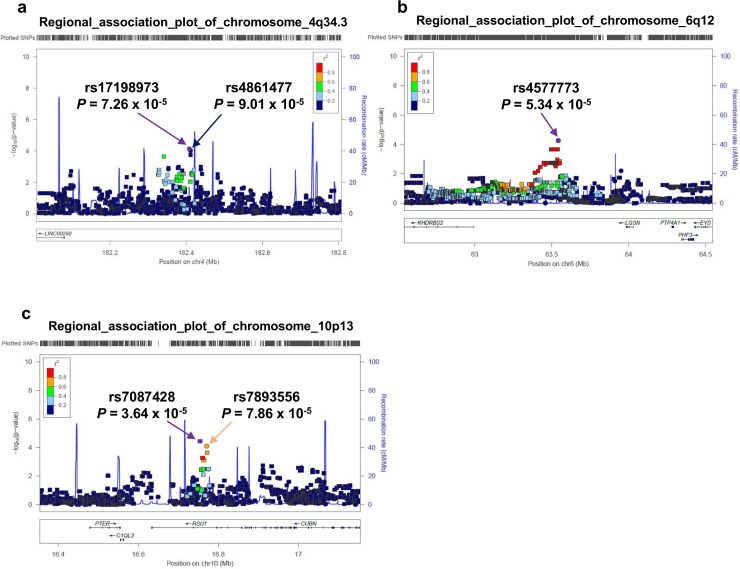
Regional association plots for three loci possibly associated with Ki-67 response after preoperative tamoxifen therapy.Upper panel; P values of genotyped SNPs (circle) and imputed SNPs (square) are plotted (as −log10P value) against their physical location on chromosome 4q34.3 (a), 6q12 (b) and 10p13 (c). The genetic recombination rates estimated from 1000 Genomes samples (JPT + CHB) are shown with a blue line. SNP's color indicates LD with rs17198973 (a), rs4577773 (b) and rs7087428 (c) according to a scale from r2 = 0 to 1 based on pair-wise r2 values from 1000 Genomes ASN. Lower panel; gene annotations from the University of California Santa Cruz genome browser.